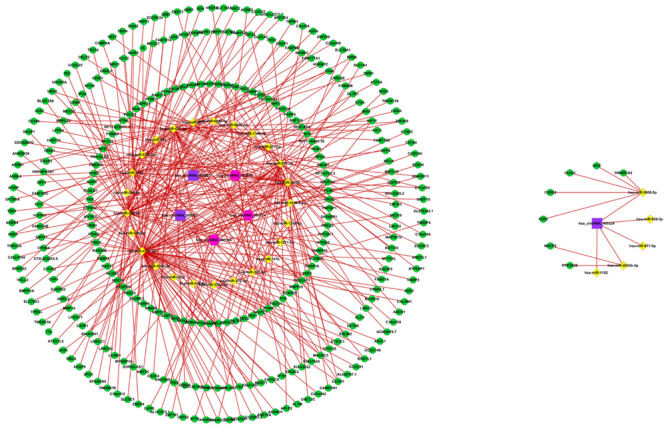
circRNA–miRNA–mRNA regulatory network. Up-regulated circRNAs, down-regulated circRNAs, miRNA, and mRNA are presented as square, hexagon, diamond, and circle, respectively.